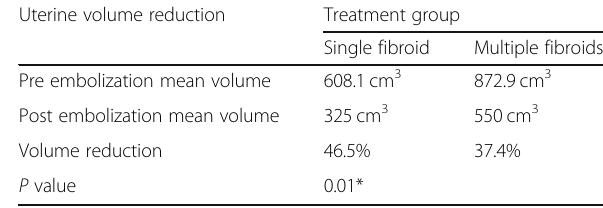
Table 1 Number, age, and complaints of the two studied groups